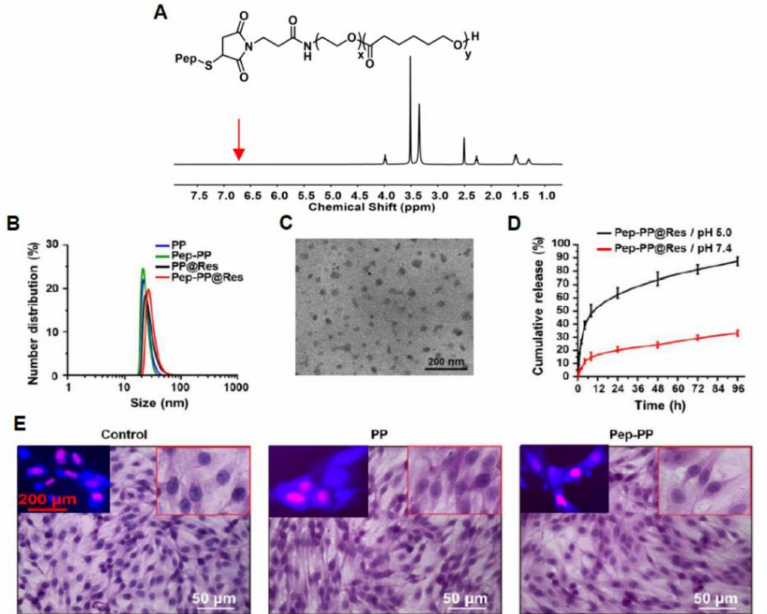
Figure 2. Construction and characterization of encapsulated resveratrol and IL-13R α 2-targeted sustained-release nanoparticles Pep-PP@Res. ( A ) 1 H NMR spectra of Pep-PEG 3.5K - b -PCL 4K in DMSO- D 6 ; ( B ) size distribution of nanoparticle formulations through DLS; ( C ) morphology of Pep-PP@Res under TEM; ( D ) in vitro release curves of Pep-PP@Res under different pH conditions; ( E ) demonstra- tion of the nontoxic effect of PP and Pep-PP on C6 cells by HE morphological staining and the EdU cell proliferation assay (upper left insets). Scale bars, 50 µ m in the main images and 200 µ m in the